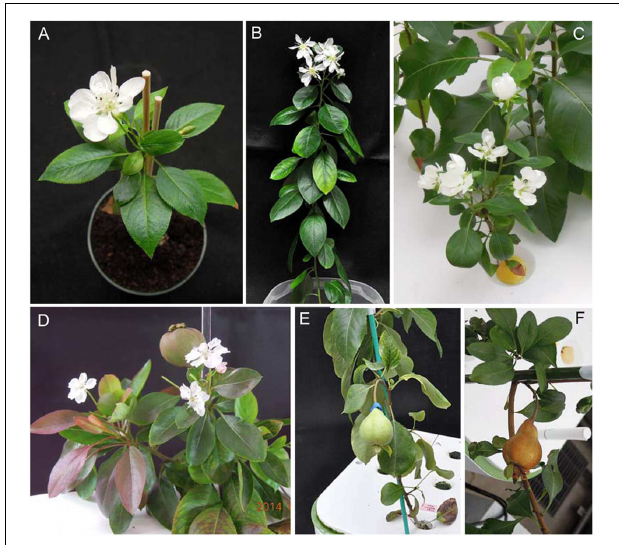
FIGURE 2 | Precocious flowering of pear seedlings infected with ALSV-AtFT/MdTFL1 (A,C–E) and ALSV-AtFT/PcTFL1(B,F).